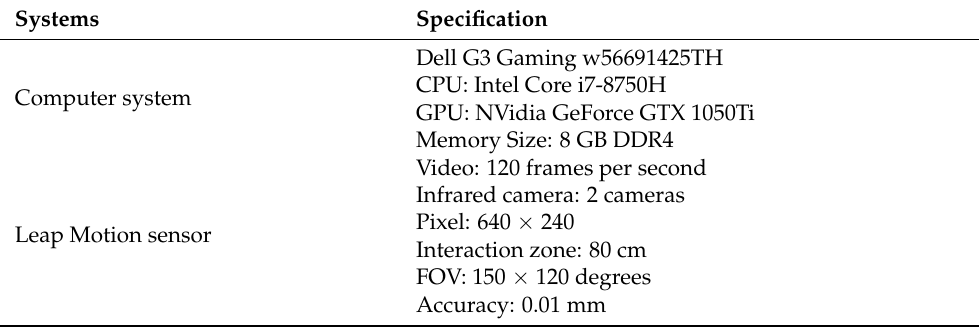
Table 3. Hardware specifications.